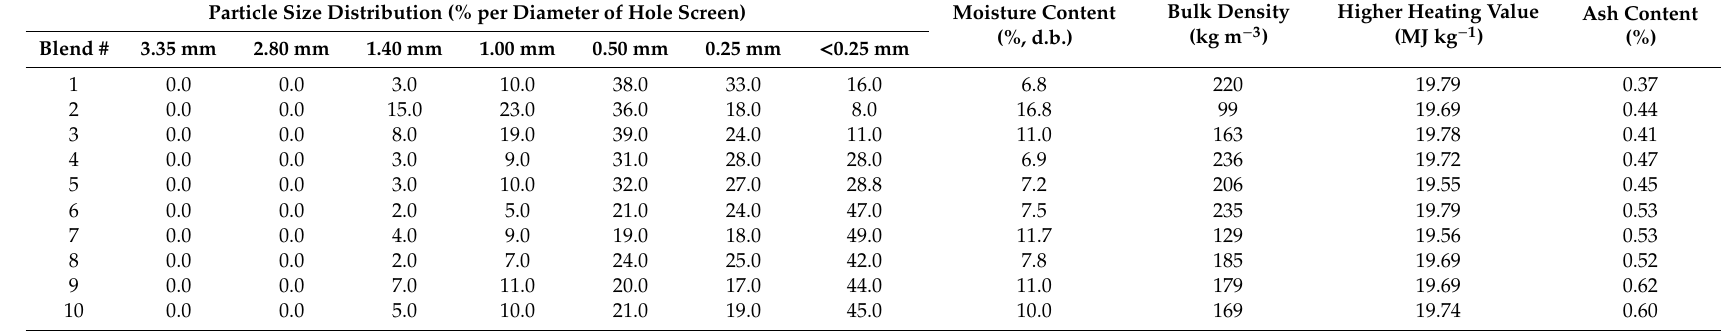
Table 2. Results of the particle size distribution analysis and other physical properties of ten blends (combinations) of residues. Values represent averages of three samples. d.b. = dry basis.